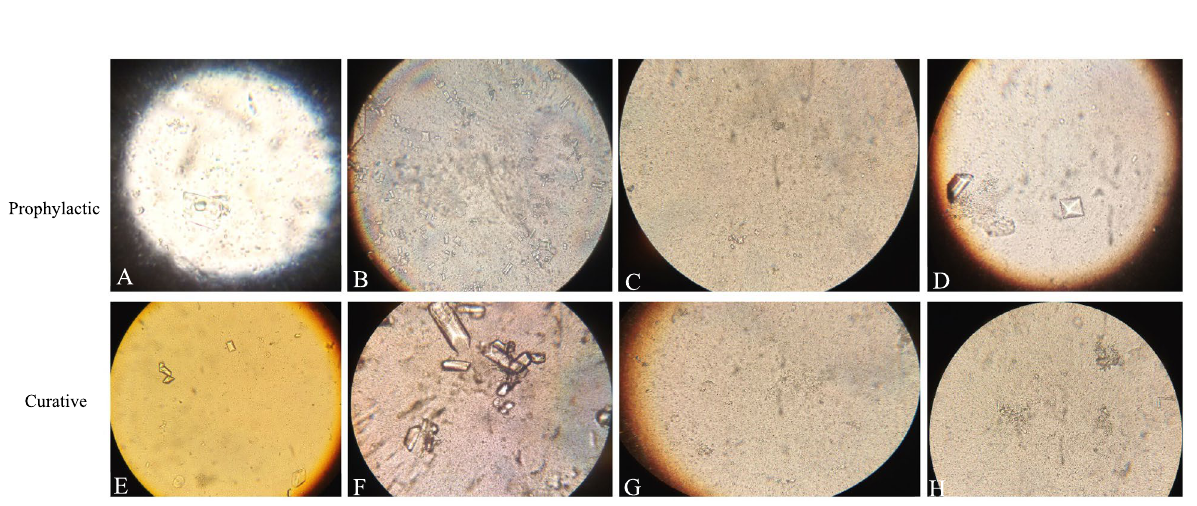
Values are expressed as mean SEM ( n 6). ANOVA post hoc with Duncan’s test was performed to compare between groups. Values with different row superscript ± = letters of the same regimen are significantly different ( P < 0.05)